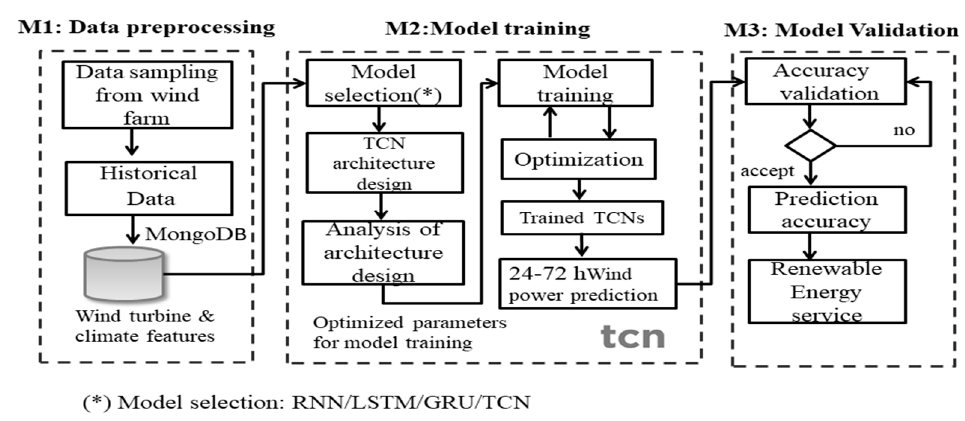
Figure 10. Experiment execution